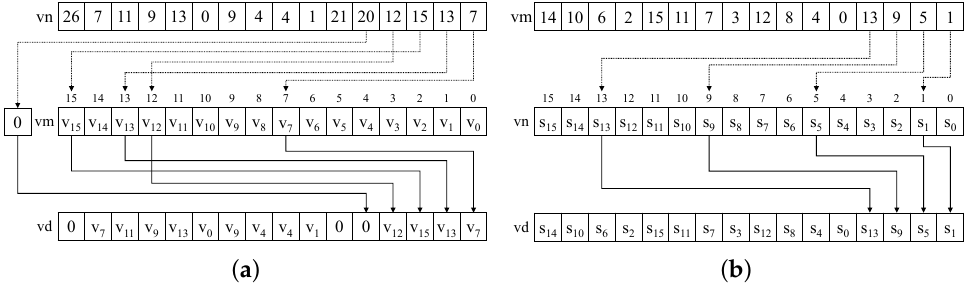
Figure 3. Usage of the TBL instruction to substitute or permutation (vn: input vector, vd: destina- tion register). ( a ) TBL.16B vd, {vm}, vn; (vm: lookup table is stored). ( b ) TBL.16B vd, {vn}, vm; (vm: